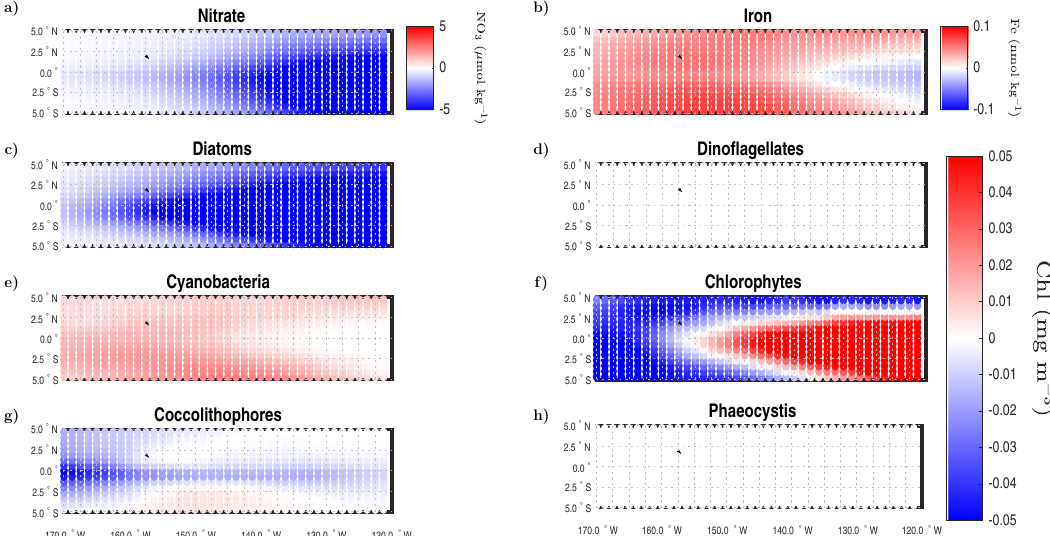
Fig. 6 Spatial pattern in ENSO 3.4 nutrient and PFTs anomalies between November of 2015 and March of 2016. a , b Mean anomaly in modeled surface ( a ) nitrate ( μ mol kg − 1 ) and ( b ) iron (nmol kg − 1 ). c – h Mean anomaly in the modeled surface chlorophyll biomass (mg m − 3 ) of ( c ) diatoms, ( d ) dino fl agellates, ( e ) cyanobacteria, ( f ) chlorophytes, ( g ) coccolithophores, and ( h )